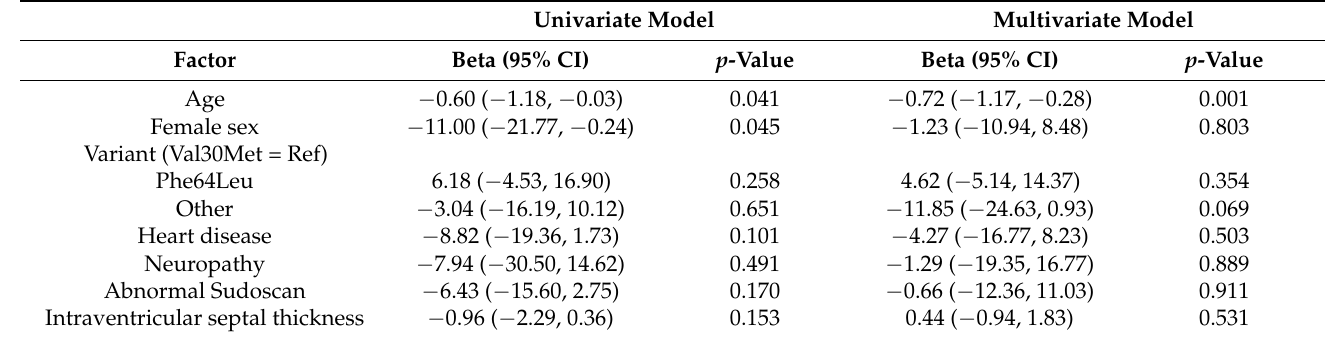
Table 2. Predictors of eGFR at any time.